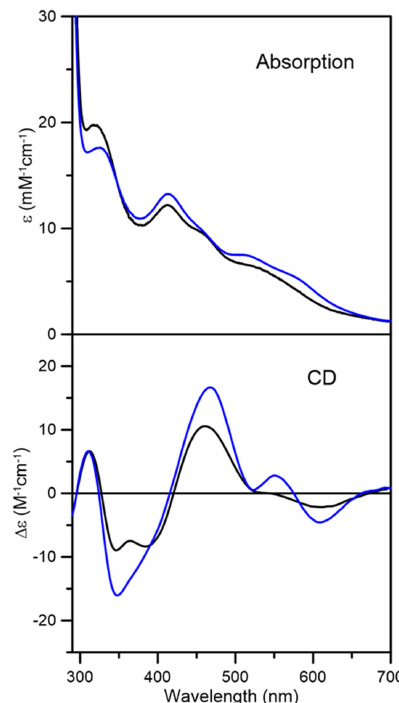
Figure 3. UV-visible absorption and circular dichroism spectra of reconstituted At GRXS15. Fraction 1 (black line) and fraction 2 (blue line) were obtained after separation using a Mono-Q column. Spectra were recorded under anaerobic conditions in sealed 0.1 cm cuvettes in 100 mM Tris- HCl buffer with 5 mM GSH at pH 7.5. The ε and Δε values are based on concentration of At GRXS15 dimer.